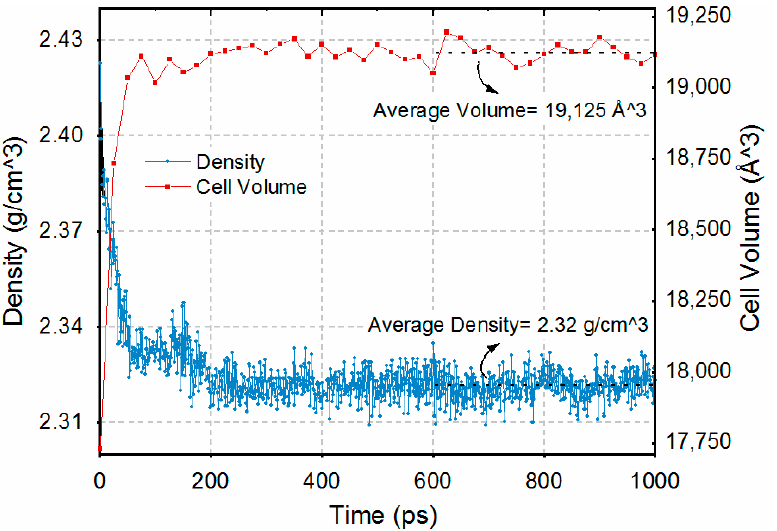
Figure 2. Density and cell volume as a function of NPT simulation time for MLC with 50% Na + and 50% K + at the water content of 160.